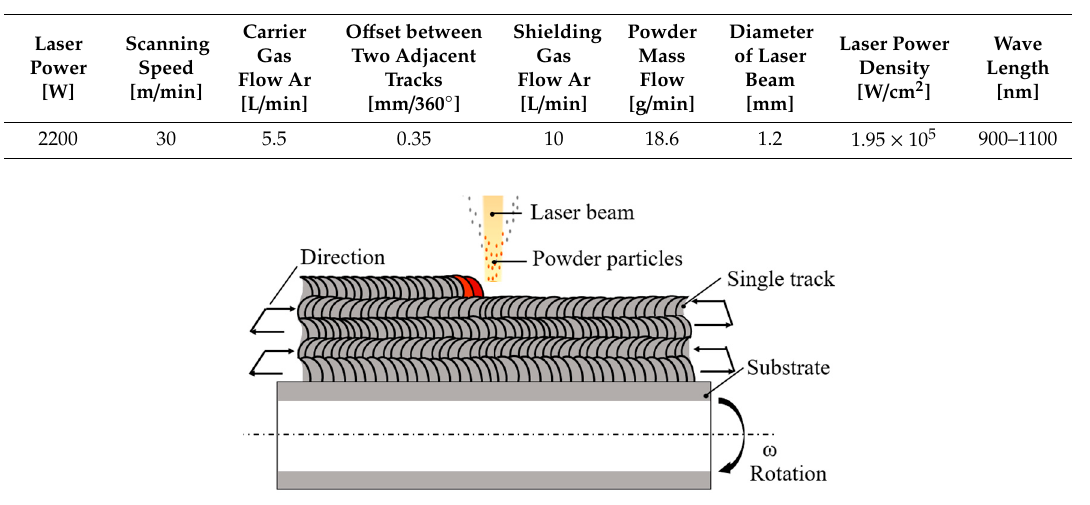
Figure 3. Scanning pattern to deposit multiple layers using EHLA.